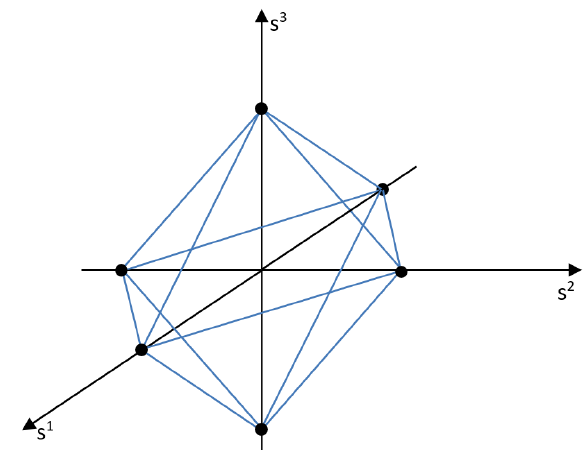
Figure 5: The fragmentation of dual space into domains for neural network with 3